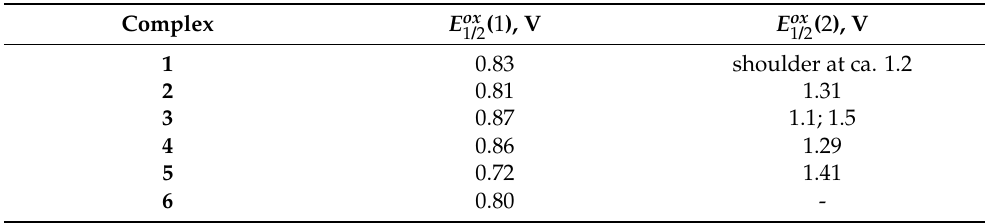
Table 1. Cyclic voltammetric data for 1 – 6 referenced to internal Fc/Fc + = 0 V; DCE (freshly distilled) solutions with [ n Bu 4 N][BF 4 ] as supporting electrolyte and scan rate of 0.1 Vs − 1 .